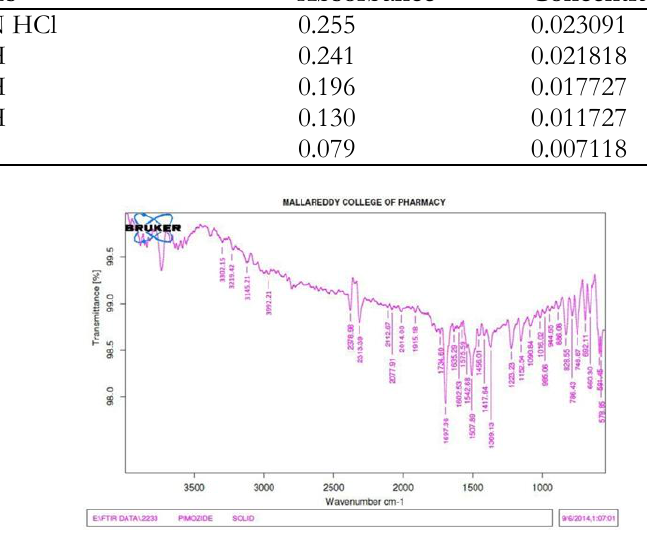
Figure 1. IR Spectra of pimozide.